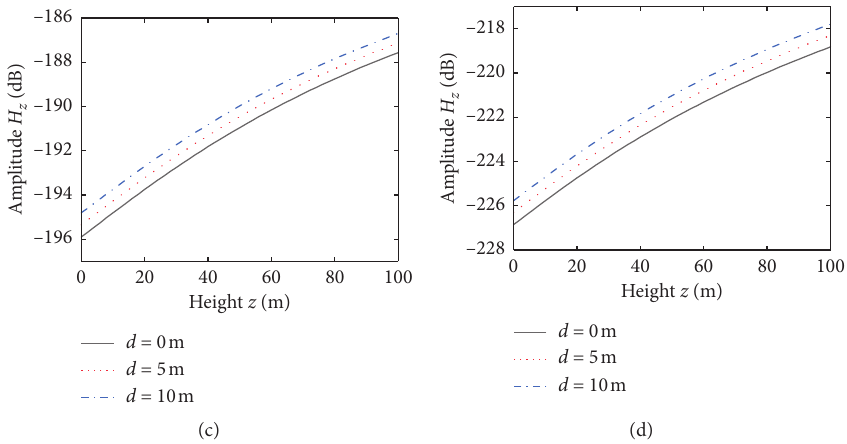
Figure 8: Amplitude of field component H versus the receiving height z : (a) ρ � 50m, (b) ρ � 100m, (c) ρ � 500m, and (d) ρ � 1000m. 2 z